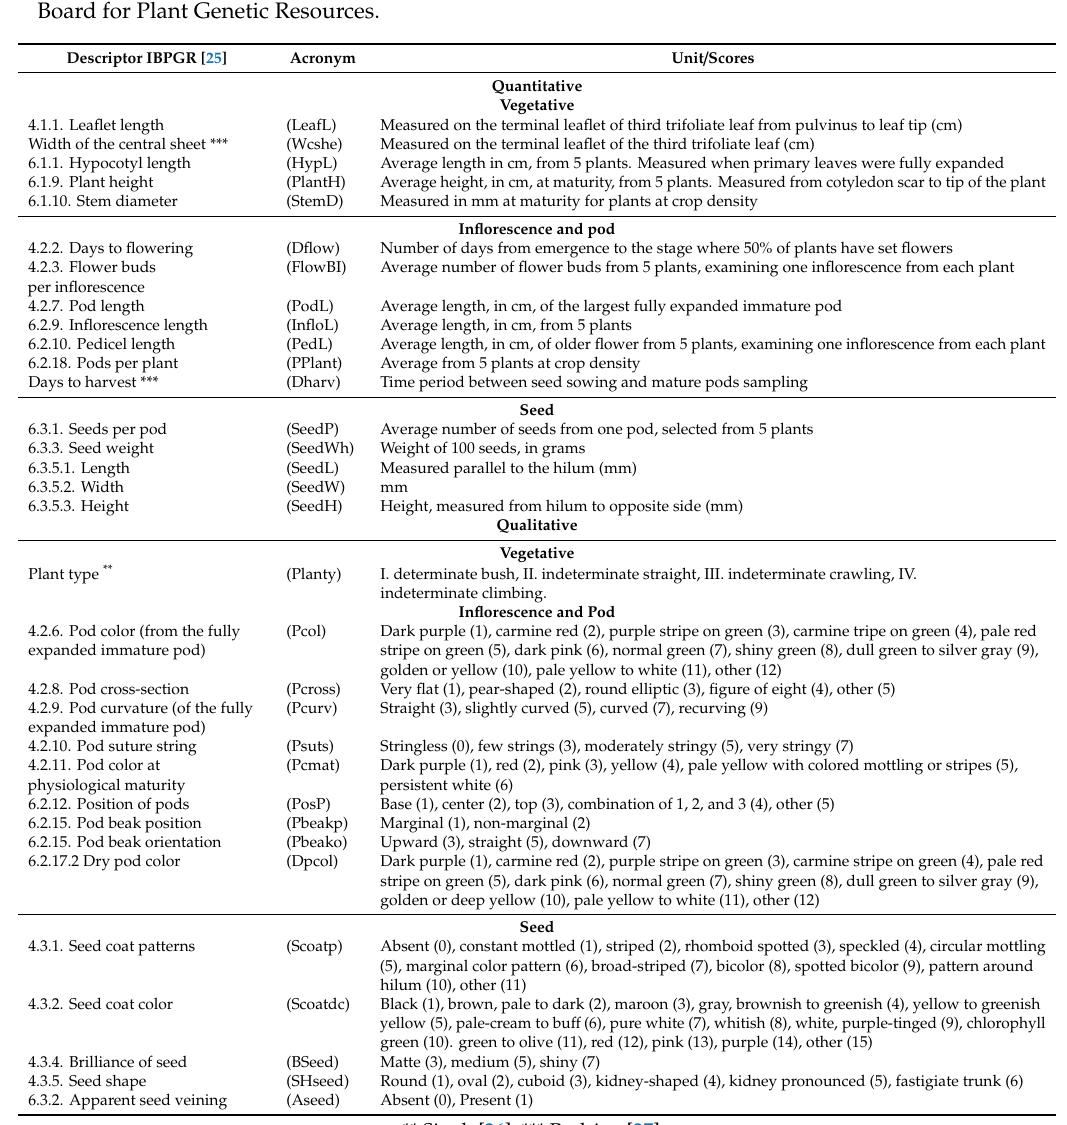
I. determinate bush, II. indeterminate straight, III. indeterminate crawling, IV. indeterminate